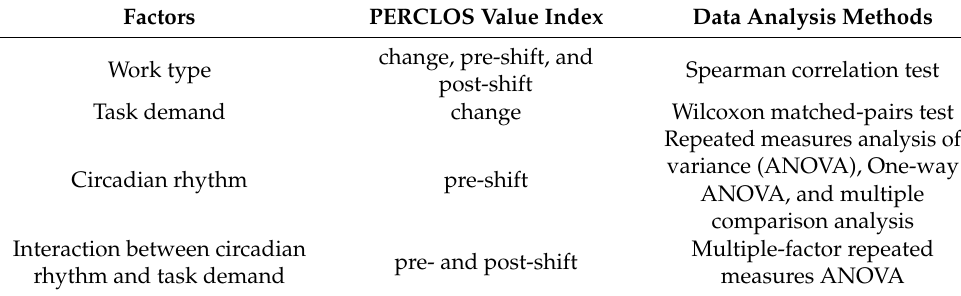
Table 5. Data analysis methods of the PERCLOS